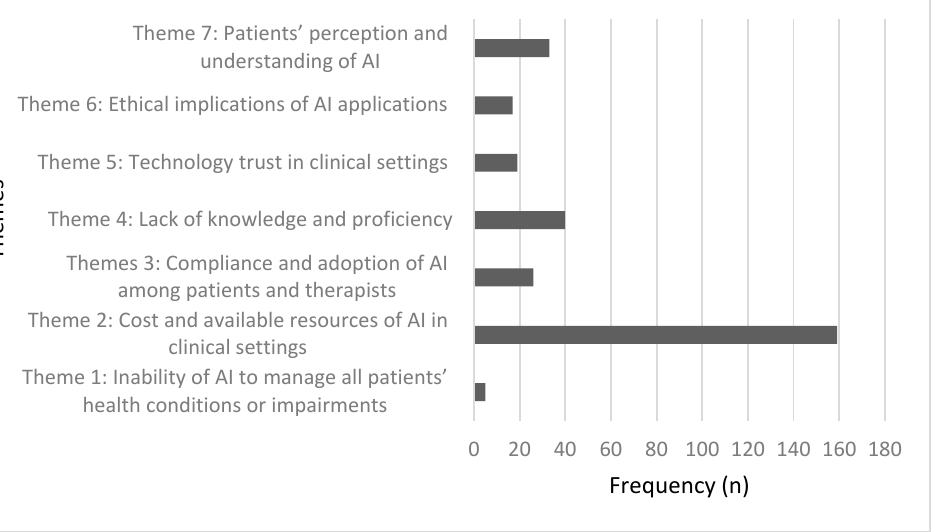
Figure 3. Frequency of the main themes generated from PTs’ responses to the second open-ended question. Cost and available resources of AI were the frequently documented barrier to AI adoption among PTs.